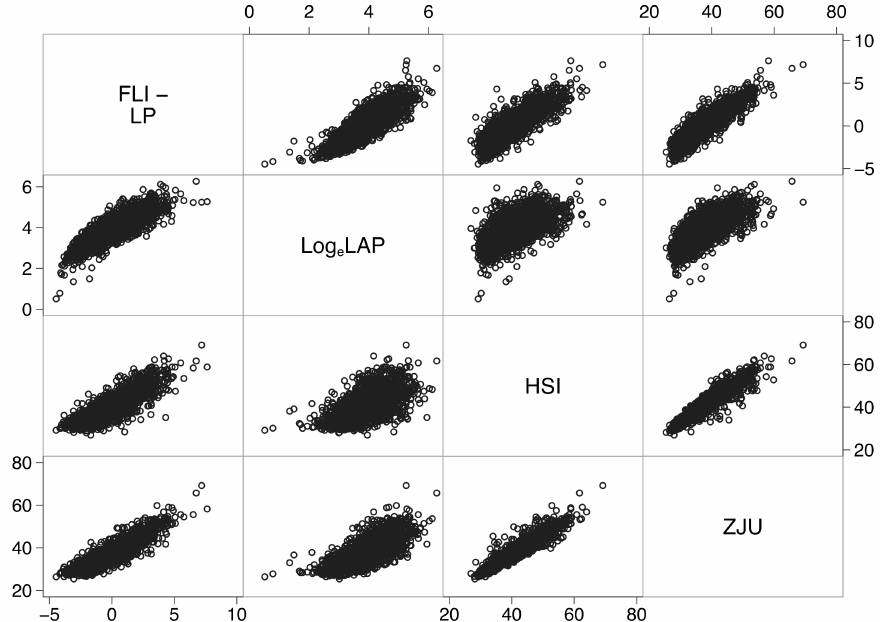
Figure 3. Correlation matrix showing strong associations between all biomarkers. Abbreviations: FLI-LP = fatty liver index-linear predictor (see Table A3 of Appendix B); Log e LAP = natural logarithm of the lipid accumulation product; HSI = hepatic steatosis index; ZJU = Zhejiang